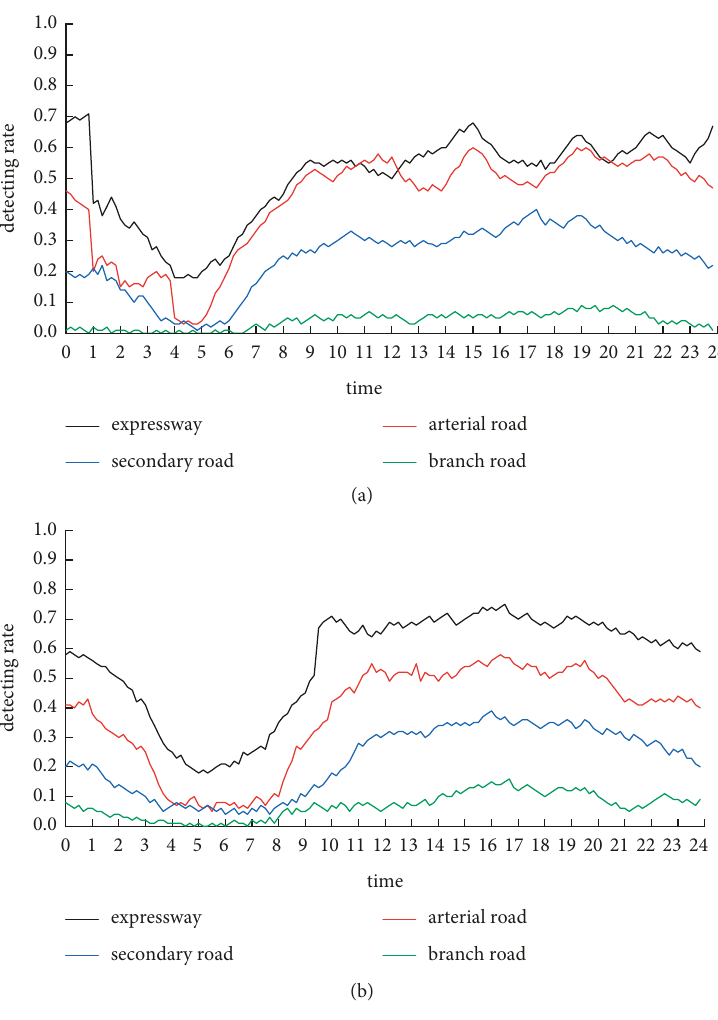
Figure 4: Detecting rate of ride-hailing vehicles on different types of roads. (a) Working day. (b)